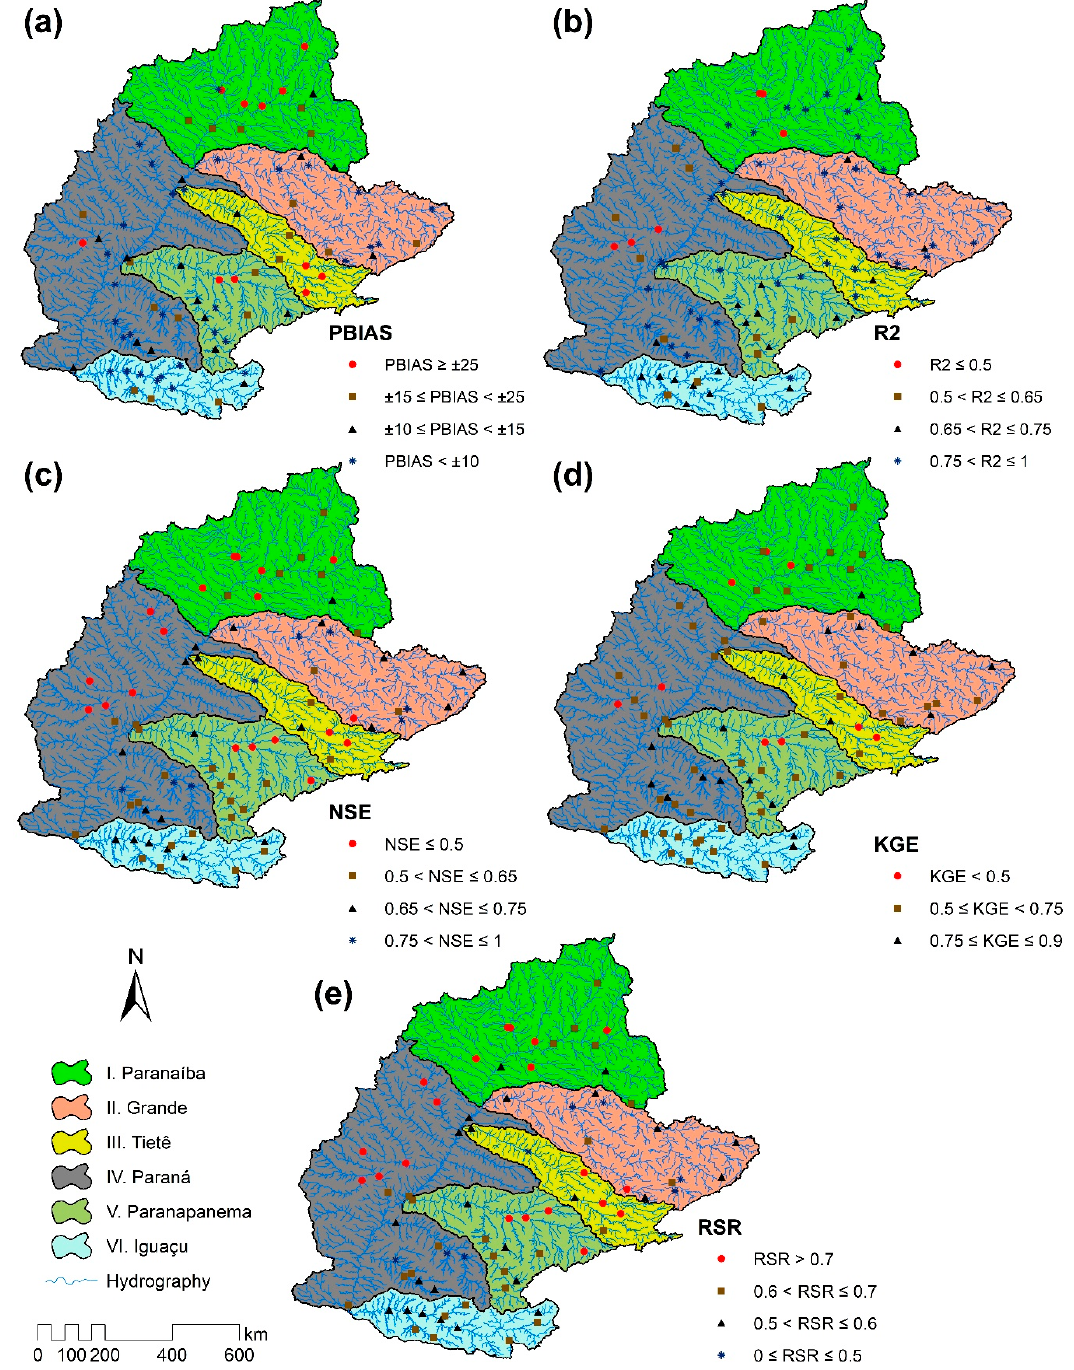
Figure 5. Spatial distribution of the performance rating of the outlets over UPRB. ( a ) PBIAS, ( b ) R 2 , ( c ) NSE, ( d ) KGE, and ( e ) RSR.